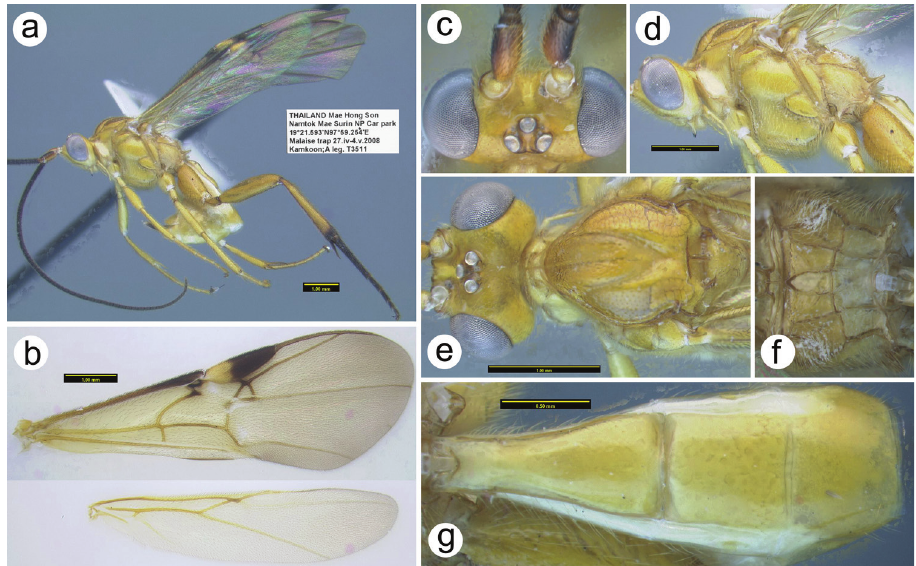
Figure 18. Zelodia toyae sp.n. a lateral habitus b wings c dorsal head d lateral head and mesosoma e dorsal head and mesosoma f dorsal propodeum g dorsal